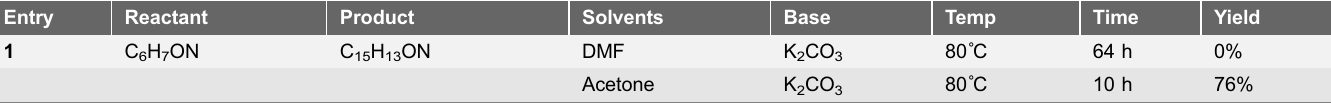
Table 5. Optimization of reaction conditions for compound 10